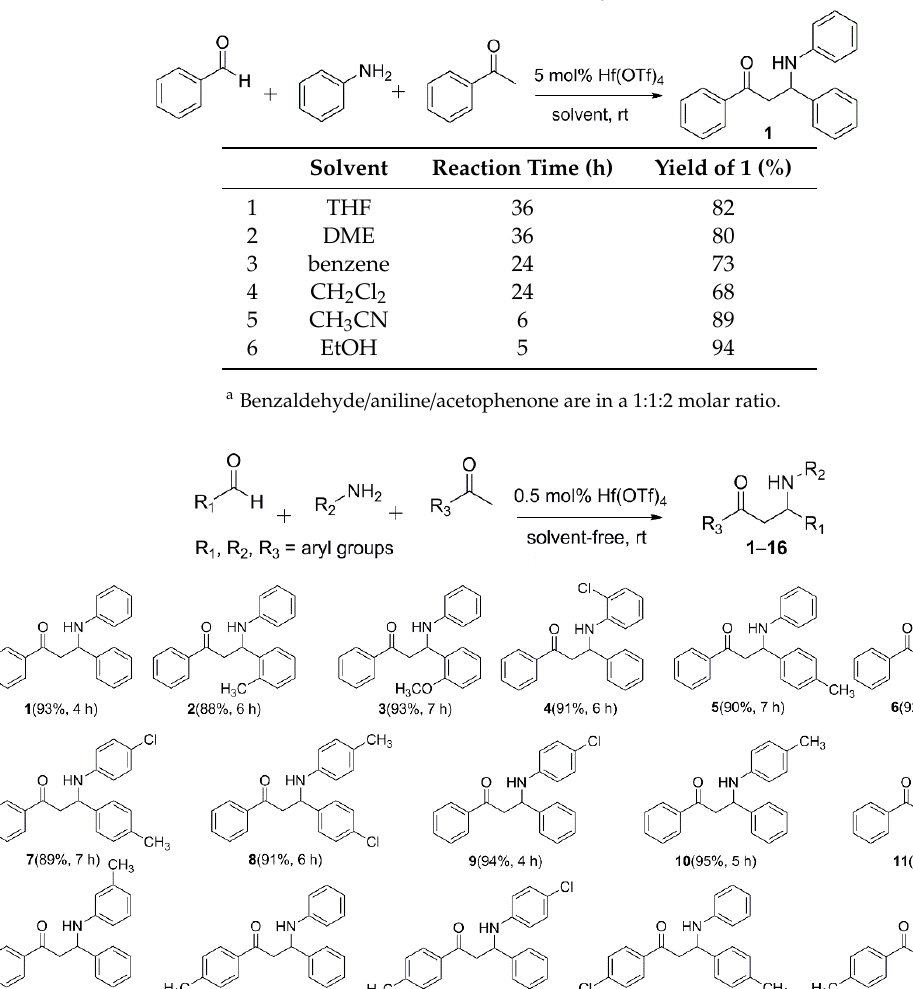
Table 2. Solvent effect on the Hf(OTf) 4 -catalyzed Mannich reaction a Table 2. Solvent e ff ect on the Hf(OTf) 4 -catalyzed Mannich reaction a .